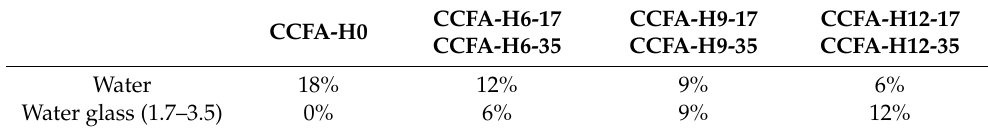
Table 5. The composition and indication of test samples for Phase 1 of the